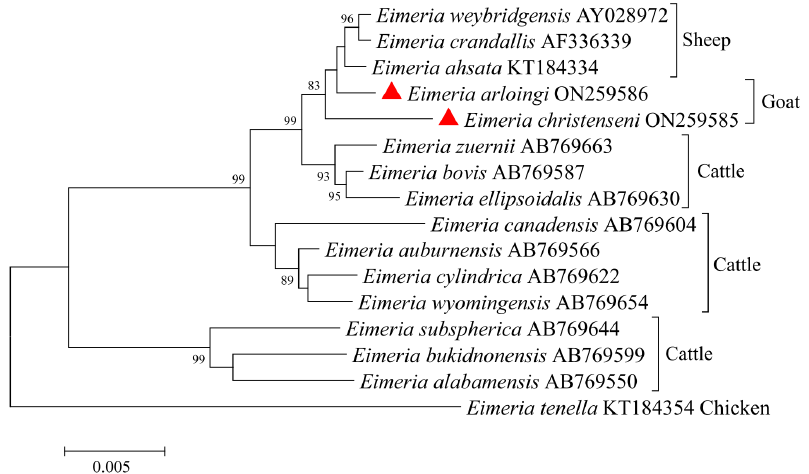
Figure 2. Phylogenetic tree generated by the Neighbor-Joining method using partial sequences of the 18S rDNA region of E. christenseni and E. arloingi from the present study and representative sequences of other Eimeria species available in GenBank. The sequences obtained in this study are marked with red triangles (bootstrap values below 75% are not indicated).